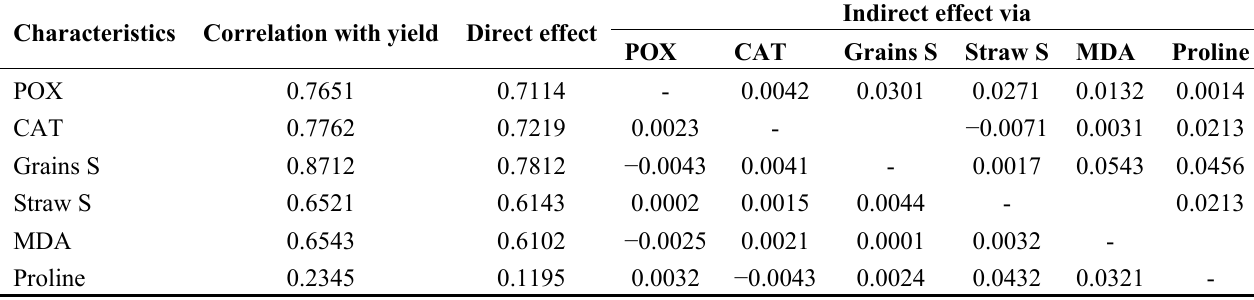
Table 4. Path coefficient analysis showing direct and indirect effects of biochemical characteristics with rice